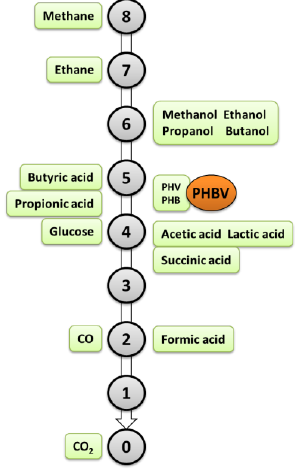
Figure 1. Degree of reduction of methane relative to other feedstocks, metabolites, PHB (CH 1.5 O 0.5 : 4.5), and PHV (CH 1.6 O 0.4 : 4.8). The degree of reduction is of a measure of the oxidation potential, with high oxidation potential indicating higher potential for energy release upon oxidation. The figure is modified from Kracke and Kromer [29] and Pratt [30].